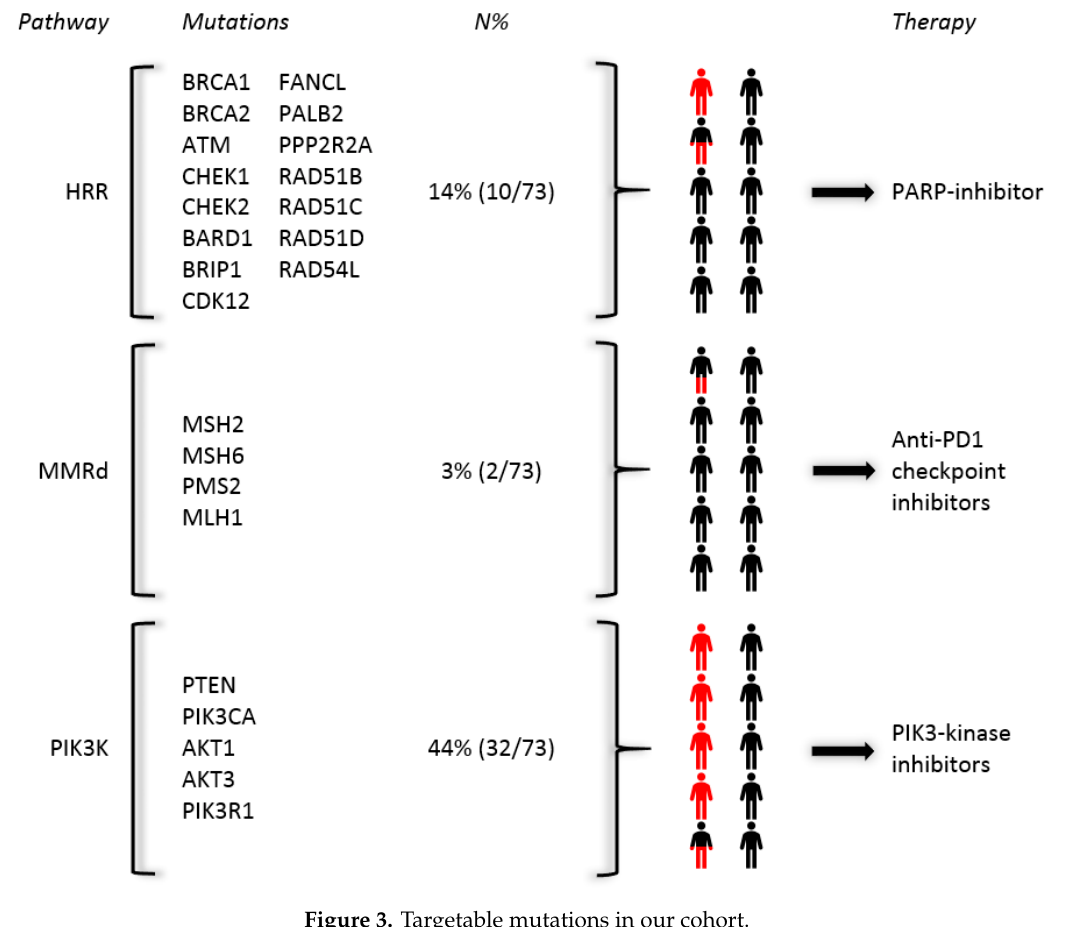
Figure 3. Targetable mutations in our cohort.